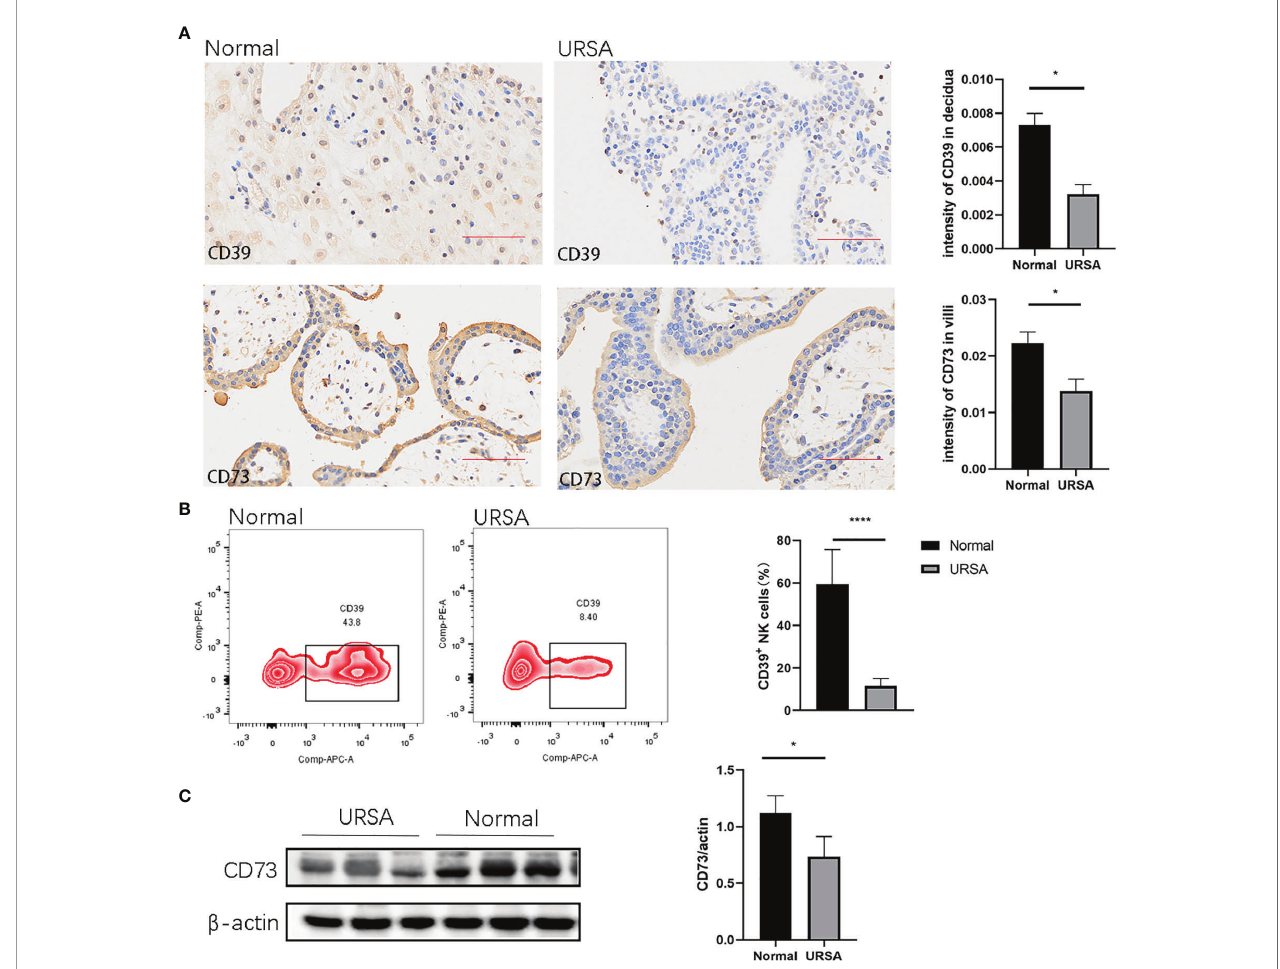
FIGURE 1 | Expression of CD39 and CD73 in normal pregnancy and URSA patients. (A) Immunohistochemical staining of CD39 in decidual tissues and CD73 in villous tissues in normal pregnancies (n=3) and URSA patients (n=3). (B) Percentages of CD39 + dNK cells in the decidual tissues of normal pregnant women (n=6) and URSA patients (n=6). (C) Western blot analyses of CD73 in the villous tissue of normal pregnant women (n=3) and URSA patients (n=3). Results are shown as mean ± SEM, *P < 0.05, ****P < 0.0001 by two-tailed t tests. AOD, average optical